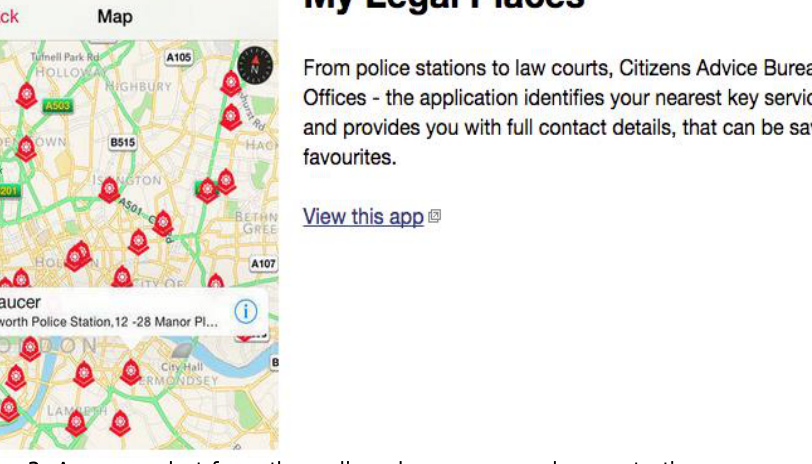
Figure 3: A screenshot from the police.uk apps page demonstrating an example of an app created using open crime and justice data. My legal places 28 provides users with details of their nearest police station, court, citizen advice bureau and community legal